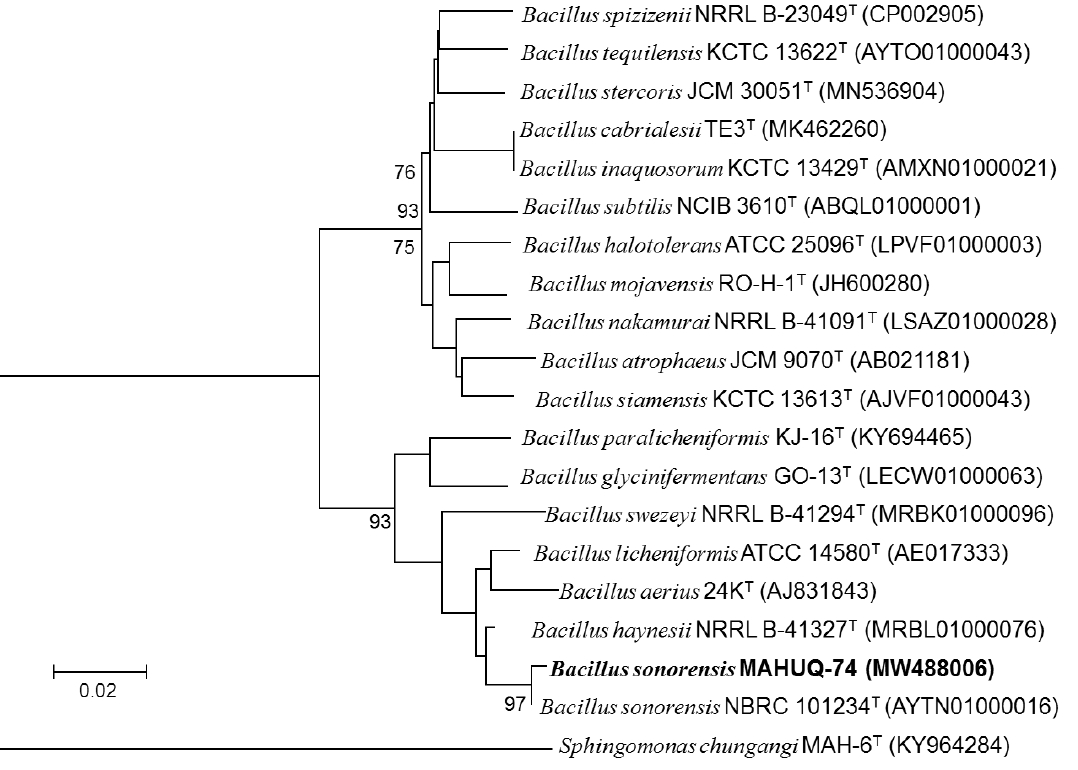
Figure 1. The neighbor-joining (NJ) tree is based on 16S rRNA gene sequence analysis, showing the position of Bacillus sonorensis MAHUQ-74 and other Bacillus species. Table 1. Biochemical characterization of Bacillus sonorensis MAHUQ-74.